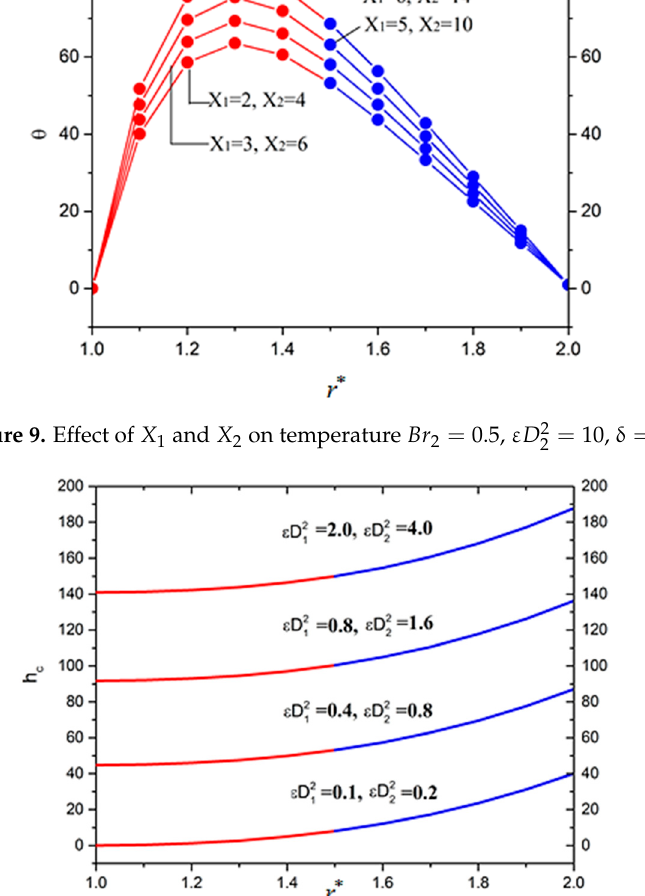
Figure 10. Effect of ε D 2 on thickness of coated fiber optics when X 1 = 0.5, X 1 = 1.0, δ = Figure 10. Effect of ε𝐷 (cid:2869)(cid:2870) on thickness of coated fiber optics when 𝑋 (cid:2869) = 0.5, 𝑋 (cid:2869) = 1.0 , δ = 2. Figure 10. Effect of ε𝐷 (cid:2869)(cid:2870) on thickness of coated fiber optics when 𝑋 (cid:2869) = 0.5, 𝑋 (cid:2869) = 1.0 , δ = 2. 1